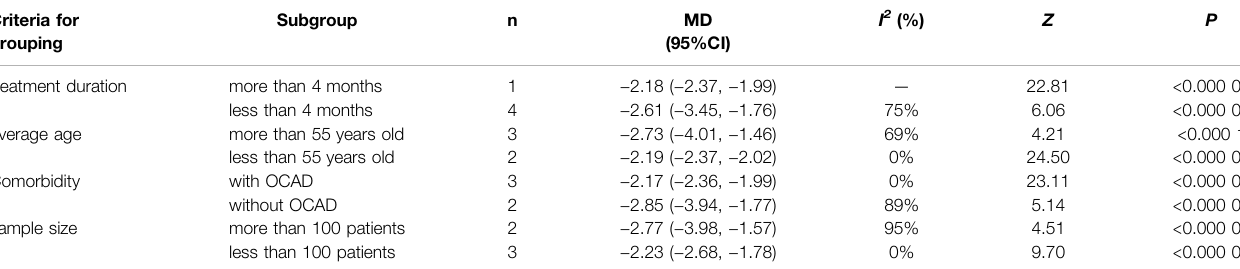
OCAD, obstructive coronary artery disease; n, number of studies